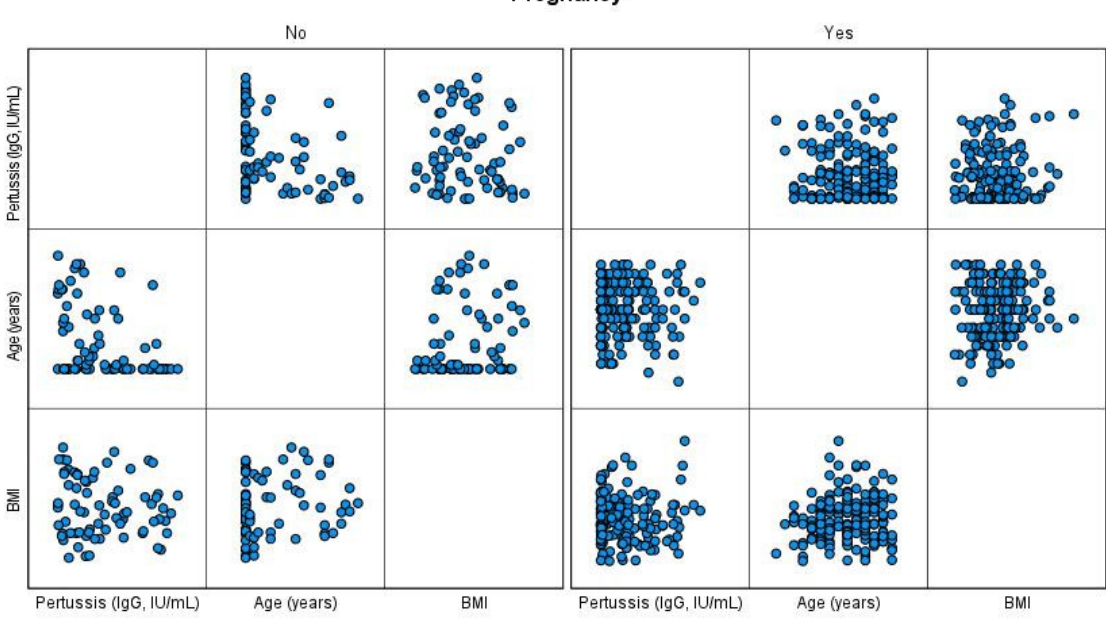
Figure 2. Scatter plots for anti-PT IgG antibody, age and BMI in pregnant and non-pregnant women. Scatter plots (Figure 2) of level of anti-PT IgG antibody (IgG, IU/mL), age (years) and BMI show no correlation in pregnant women. In non-pregnant women, the antibody level tends to decrease as the age increases.